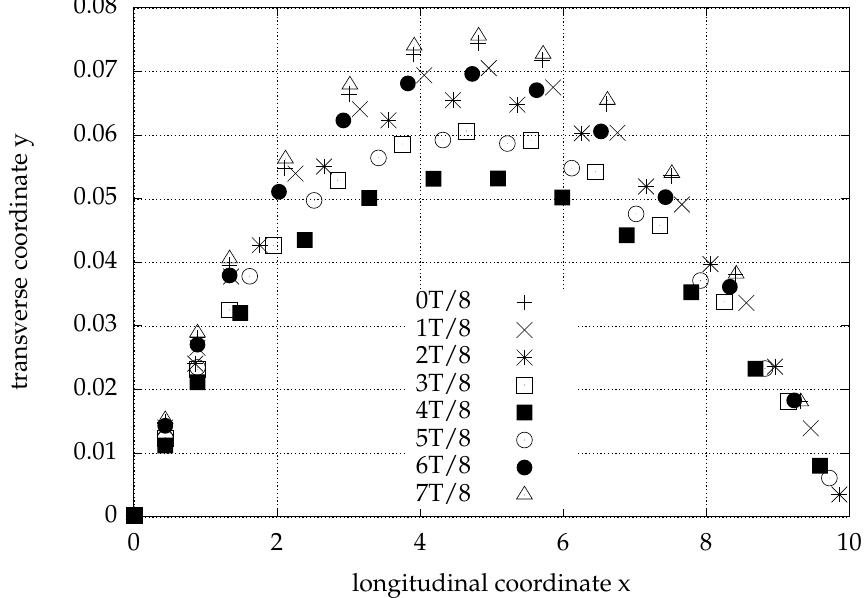
Figure 21. Shape of an elastic control membrane with length l = 10, tension T m = 55 and external pressure exerted at its outer side, p e = 0.55 for eight instances during one inflow period T . The inflow is defined by Equation (1) with α = 0.05 and ω =